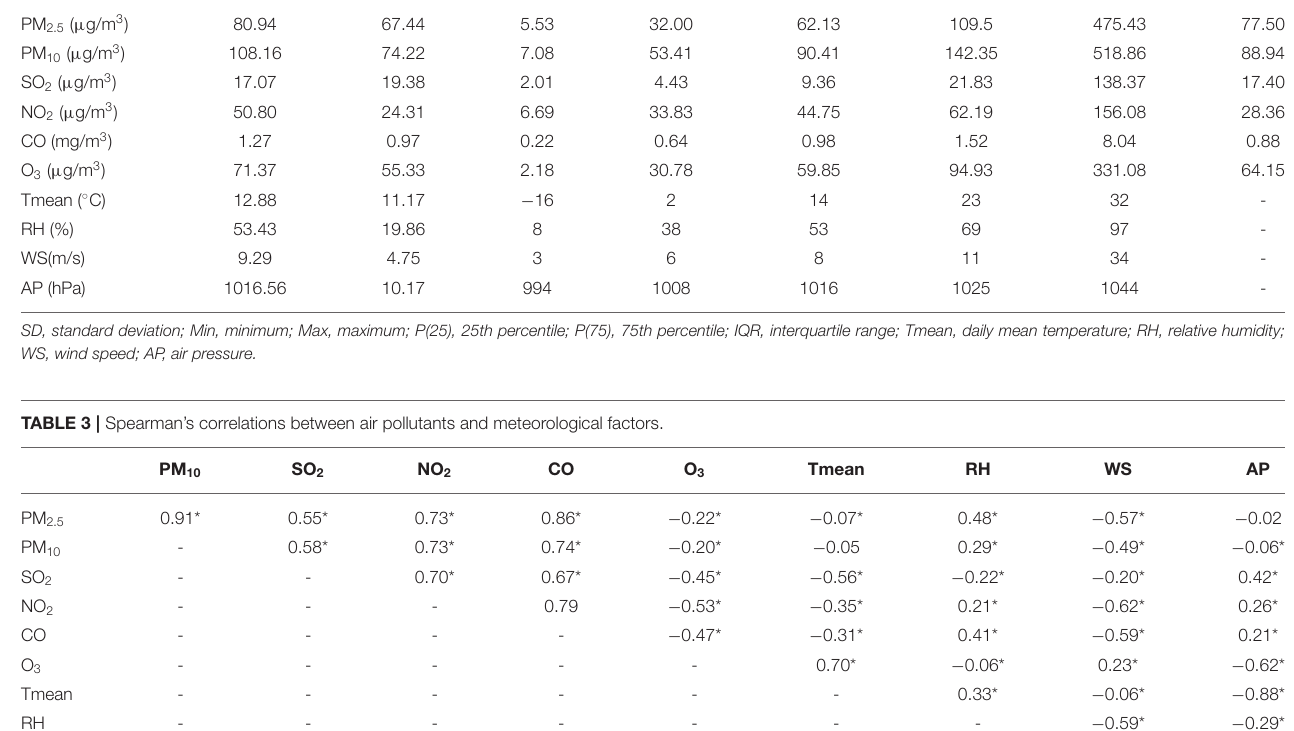
TABLE 2 | Descriptive statistics of daily air pollutants concentrations and meteorological factors in Beijing, China (2013–2016). Mean